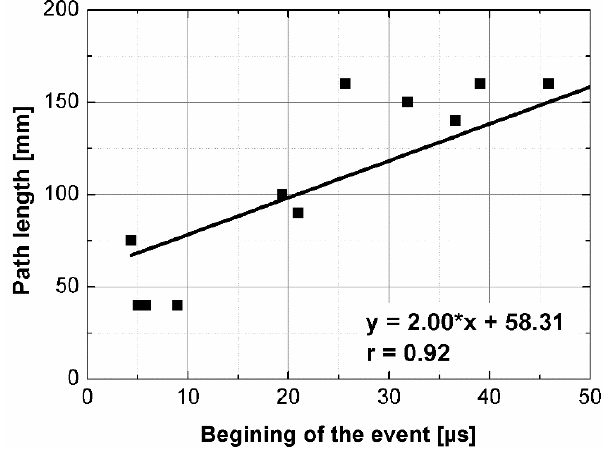
Figure 16. The beginning of the main event plotted against path length.